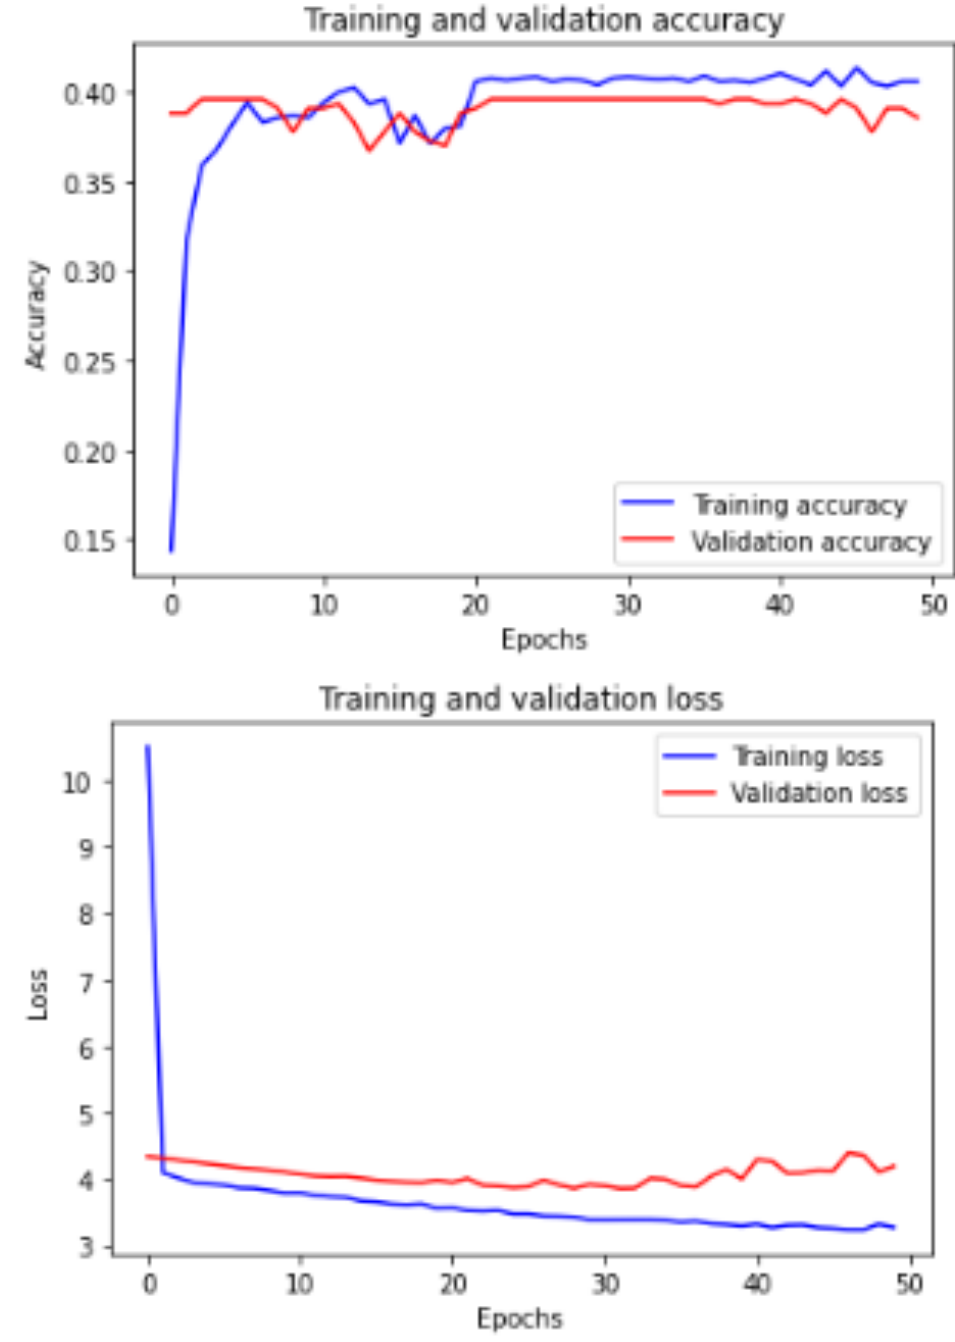
Figure 15. The training and validation ACC and loss through 50 epochs of the Xception